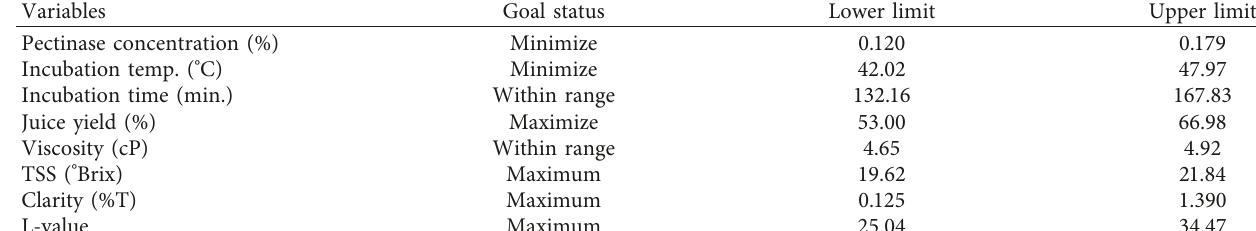
Table 4: Constraints fixed for processing condition and responses.